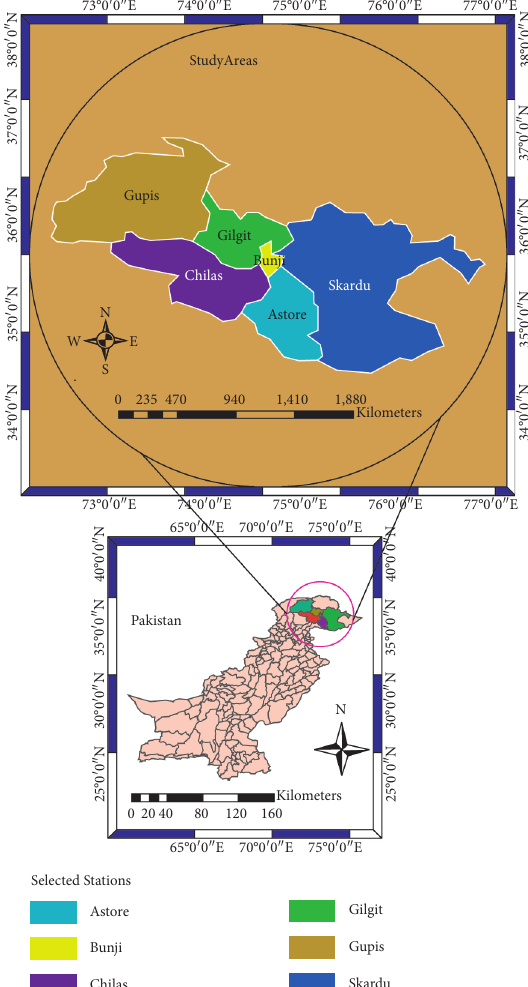
Figure 1: Selected geographical locations from the northern areas of Pakistan.